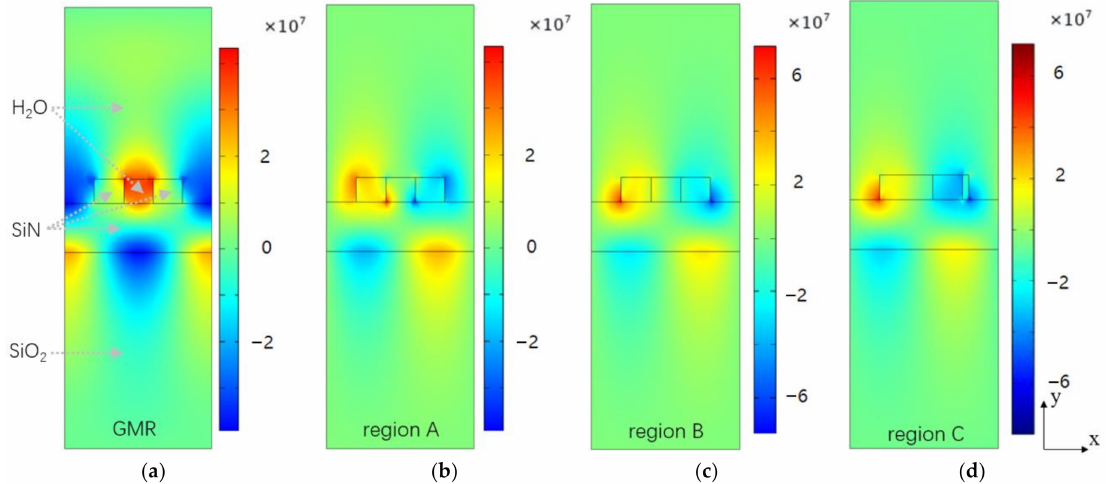
Figure 7. ( a – c ) Ex components distribution of the GMR and the BIC in region A and B when the asymmetry parameter is zero. ( d ) Ex components distribution in region C when the asymmetry parameter is 0.52. The color represents the intensity of